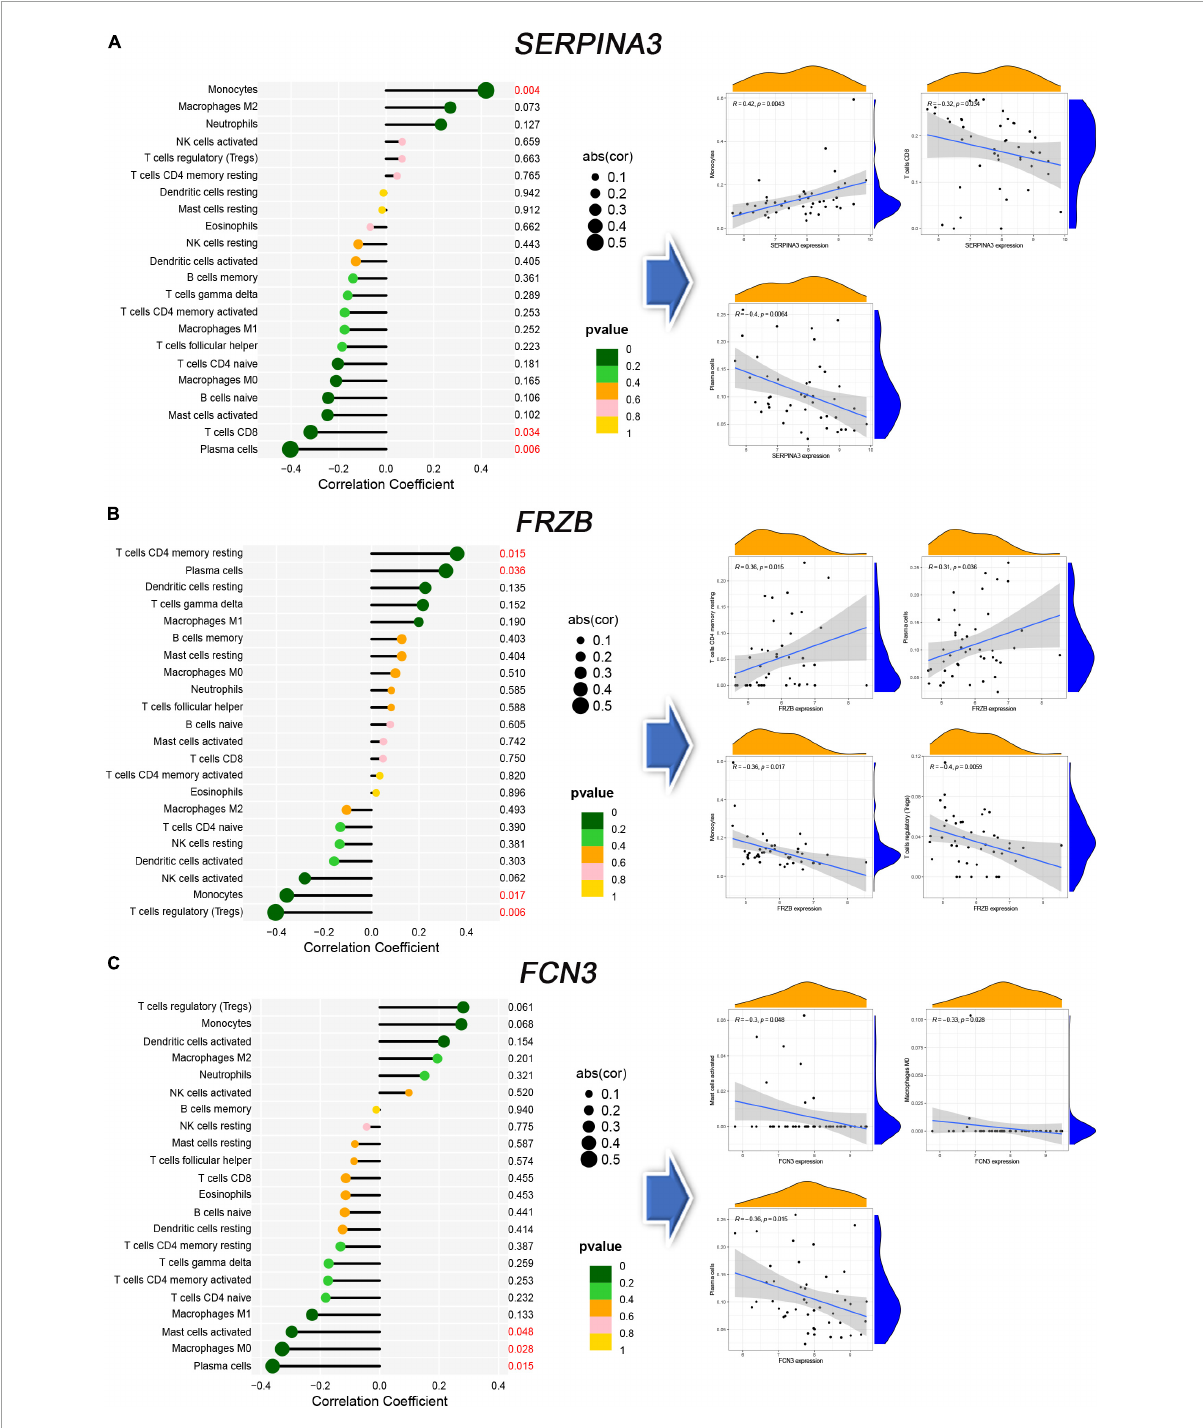
FIGURE7 The immune correlation between diagnosis genes and immune cells. (A–C) The lollipop map and linear regression map in SERPINA3, FRAB, and FCN3.